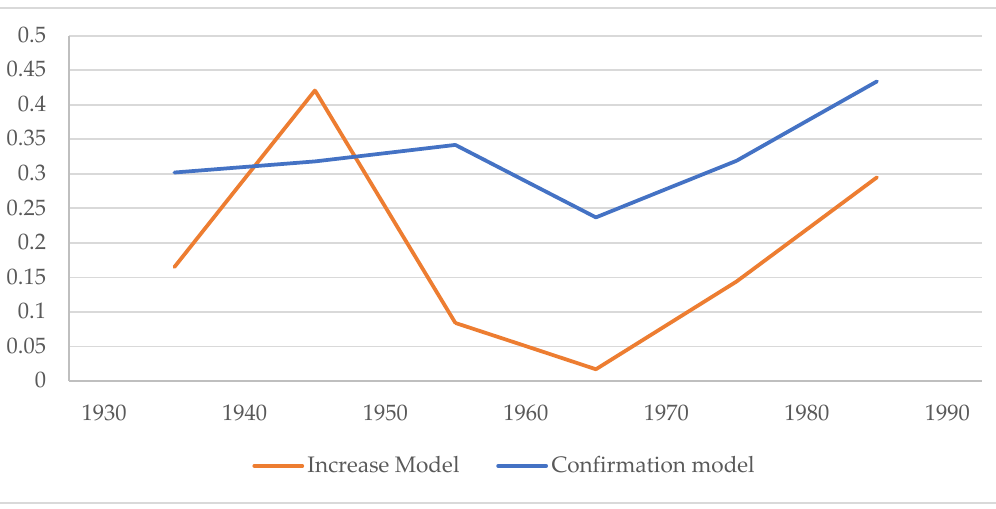
Table 3. Ordinary least squares (OLS) regression results, showing effects on the highest auction price (log transformed) and reporting the standardized coefficients.